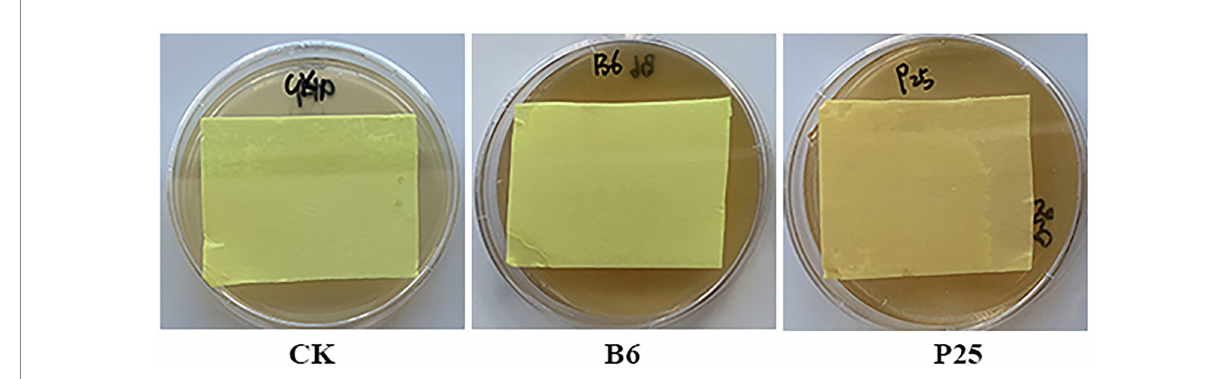
FIGURE 6 Hydrocyanic acid (HCN) produced by bacteria. CK: without bacteria; B6: Streptomyces sp. B6; P25: Pseudomonas sp.